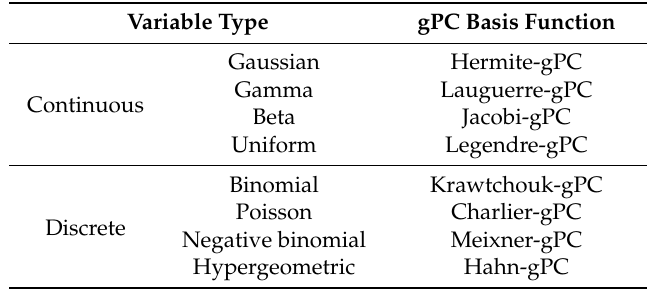
Table 1. Correspondence of gPC and their underlying random